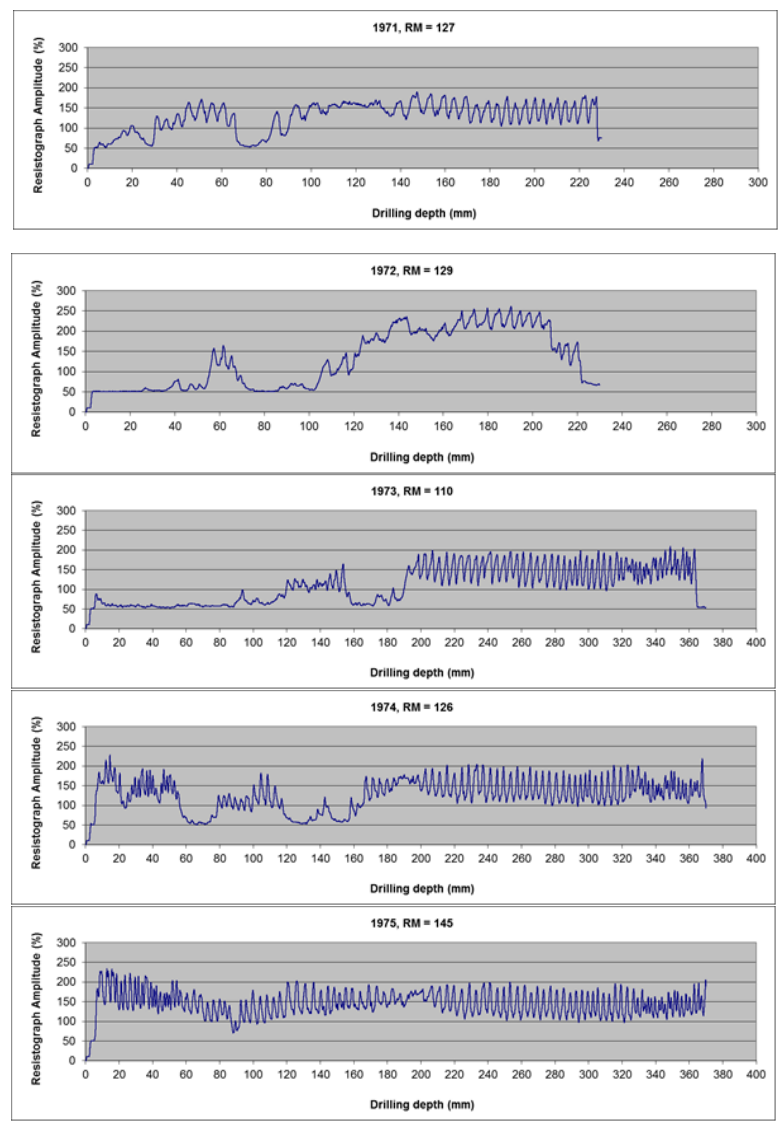
Figure 21. Graphic records from the individual measurement points using the Resistograph drill, beam (I2), measured vertically in the centre of the element.